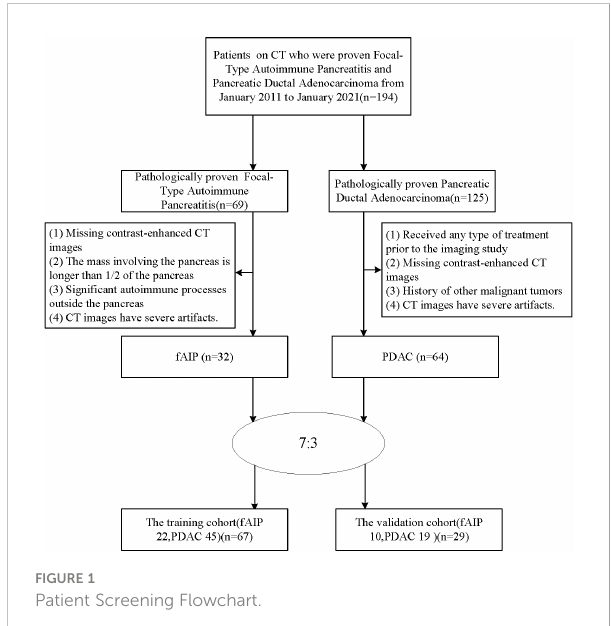
FIGURE 1 Patient Screening